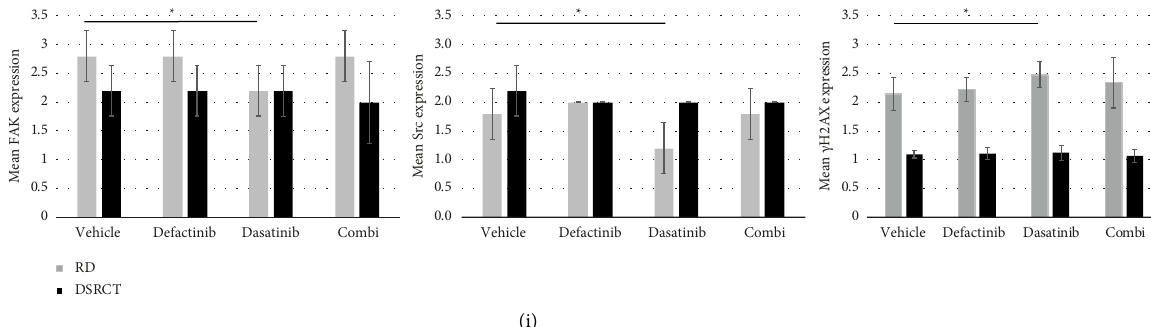
Figure 6: In vivo assessment of defactinib and dasatinib combination treatment in a DSRCTand ERMS model. (a) Relative tumor volume (RTV) following 28 days of vehicle, defactinib (50 mg/kg/day), dasatinib (50mg/kg/day), and combination treatment in the JN-DSRCT-1 in vivo model. (b) Relative tumor volume (RTV) following 21 days of vehicle, defactinib (50mg/kg/day), dasatinib (50mg/kg/day), and combination treatment in the RD in vivo model. (c–f) The level of viable tumor tissue (HE), caspase-3 (casp-3), pFAK, and pSrc expressions following vehicle, single-agent defactinib, single-agent dasatinib, and combination treatment in vivo in the JN-DSRCT-1 (c-d) and RD (e-f) models. The differences between pFAK and pSrc expression showed similar significance levels (i.e., p -value < 0.001) in the JN-DSRCT-1 model compared to the RD model. One representative line and asterisks are given. The level of FAK, Src, and ƴ H2AX expressions following vehicle, single-agent defactinib, single-agent dasatinib, and combination treatment in vivo in the JN-DSRCT-1 (g) and RD (h) models. The differences between FAK, Src, and ƴ H2AX expressions between treatment groups in both models (i). ∗ p -value < 0.05, ∗∗ p -value < 0.01, and ∗∗∗ p -value < 0.001. HE: hematoxylin and eosin